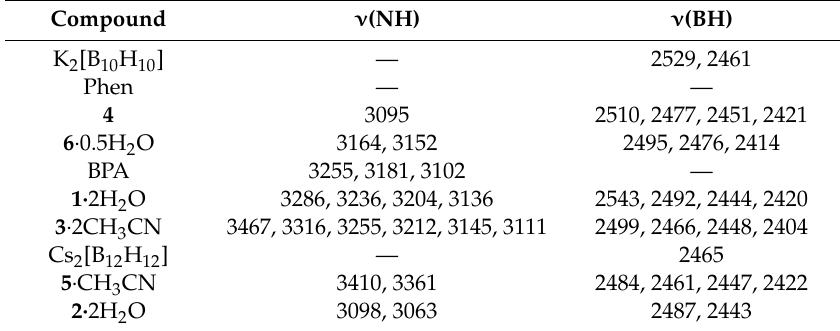
Table 1. Maxima of ν (NH) and ν (BH) absorption bands in IR spectra of compounds 1–6 as compared to alkali metal closo -borates (cm –1 ). Compound ν (NH) ν (BH) K 2 [B 10 H 10 ] — 2529, 2461 Phen — — 4 3095 2510, 2477, 2451, 2421 6 · 0.5H 2 O 3164, 3152 2495, 2476, 2414 BPA 3255, 3181, 3102 — 1 · 2H 2 O 3286, 3236, 3204, 3136 2543, 2492, 2444, 2420 3 · 2CH 3 CN 3467, 3316, 3255, 3212, 3145, 3111 2499, 2466, 2448, 2404 Cs 2 [B 12 H 12 ] 2465 3410, 3361 2484, 2461, 2447, 2422 3098, 3063 2487,